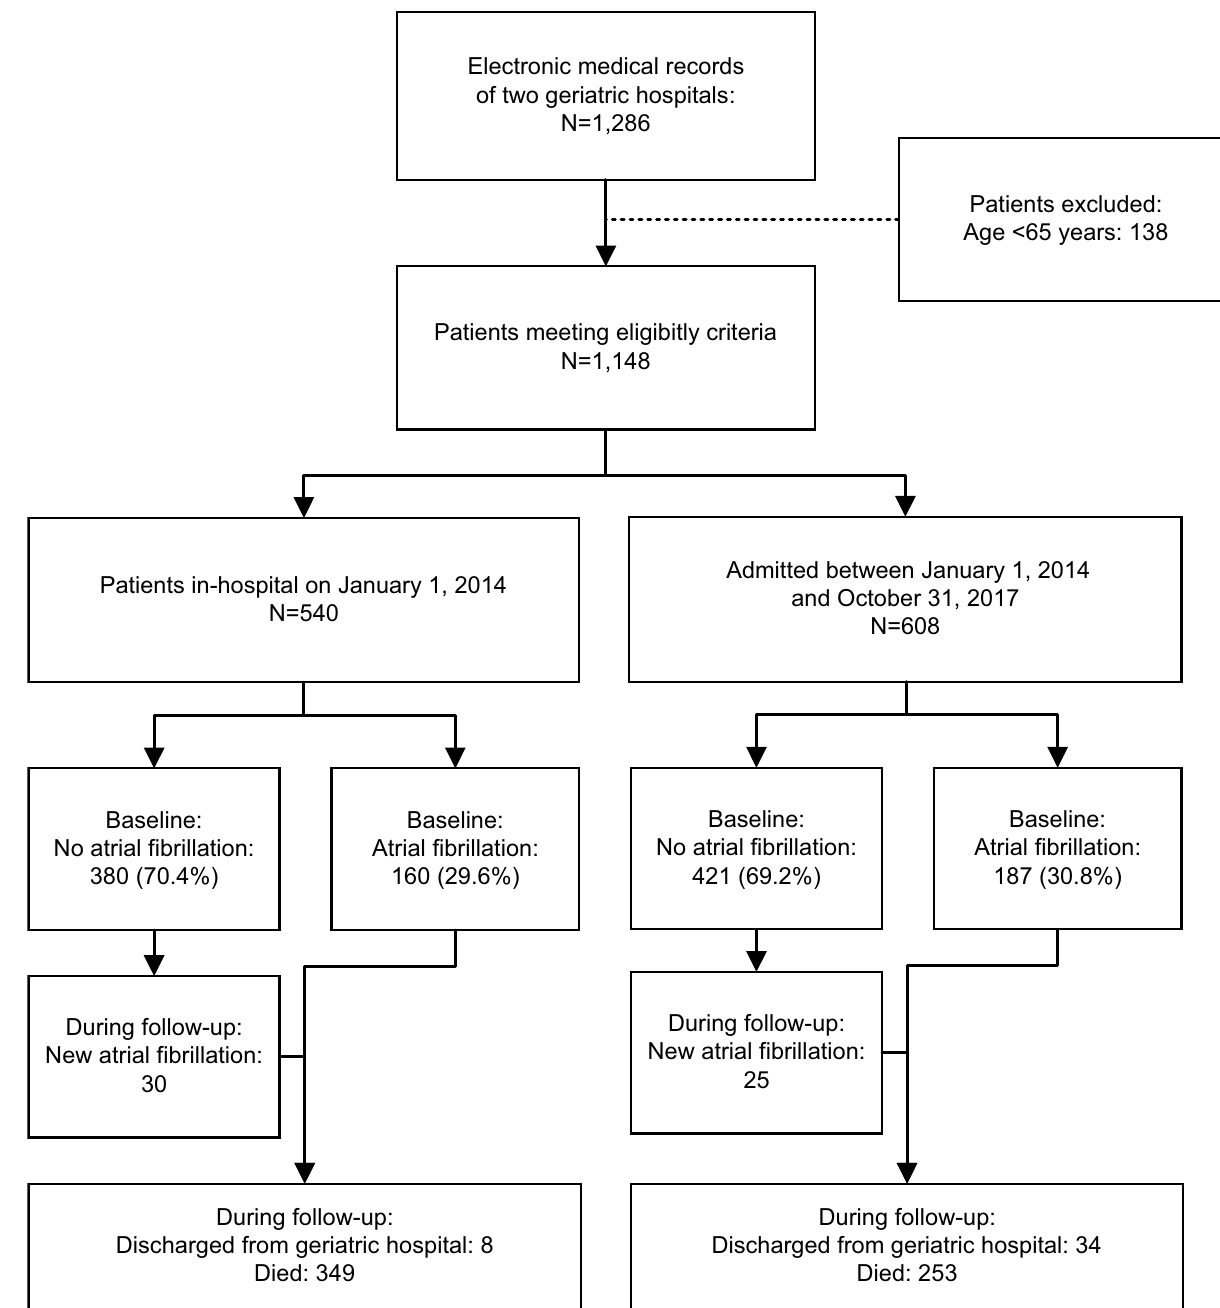
Figure 1. Flowchart of patient cohort. N, number of